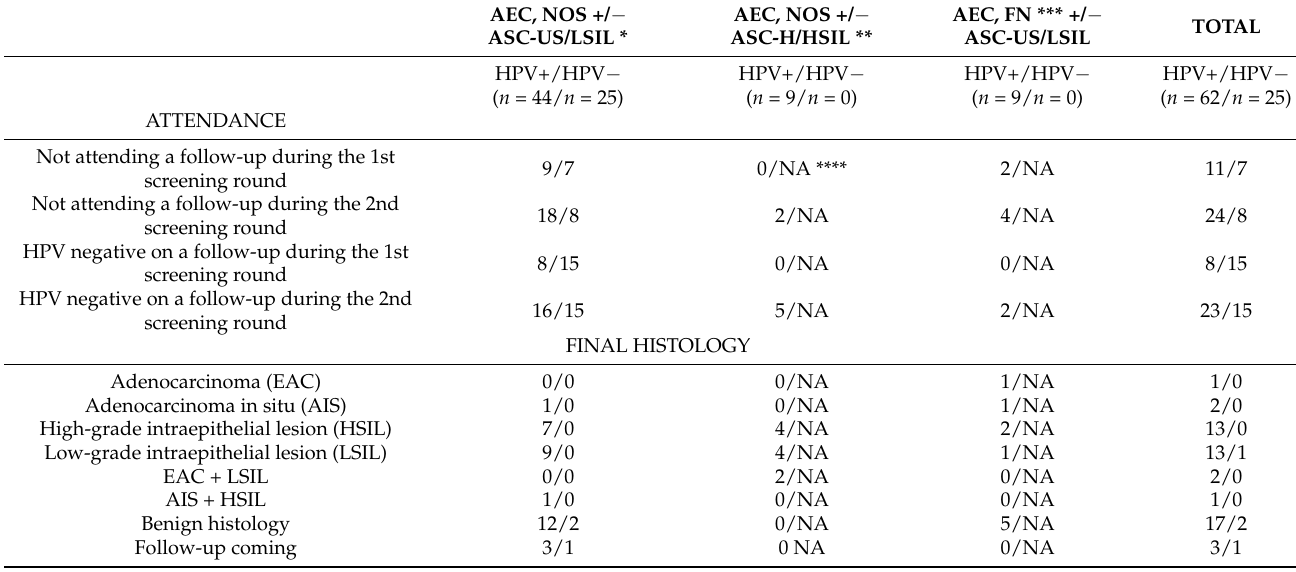
Table 2. Cytological diagnoses with HPV status and the follow-up data on two cervical cancer screening rounds (2012–2015 and 2017–2020) among patients with cytological endocervical glandular diagnosis at the first screening